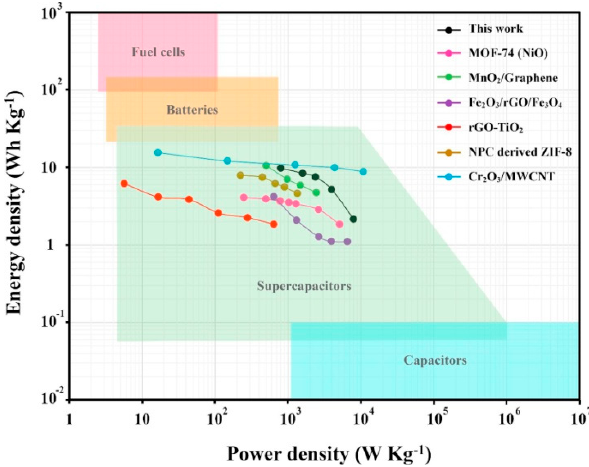
Figure 14. Ragone plots of Cr 2 O 3 /C//Fe x O y /C and other metal oxide/carbon composite-based ASCs